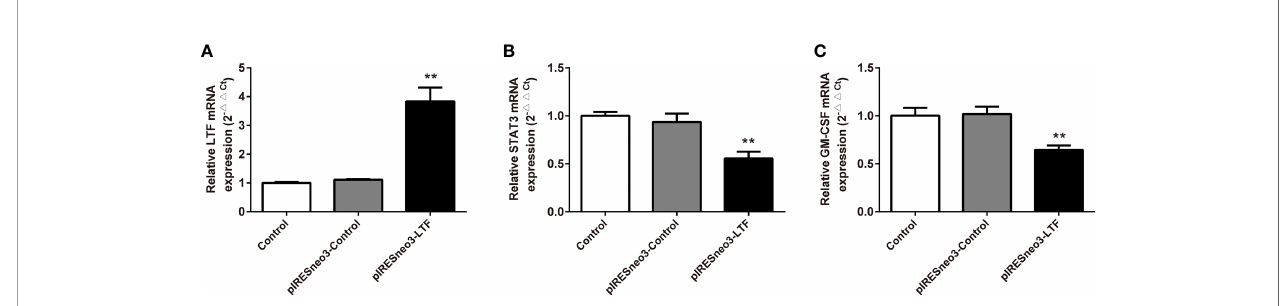
FIGURE 6 | Effect of the mRNA expressions of LTF, STAT3 and GM-CSF in PC-3. The mRNA levels of LTF, STAT3 and GM-CSF were detected by RT-PCR. The mRNA levels of LTF (A) , STAT3 (B) and GM-CSF (C) were normalized to control. The results were presented as mean ± SD (n = 3). **p < 0.01 vs . pIRESneo3-Control group.